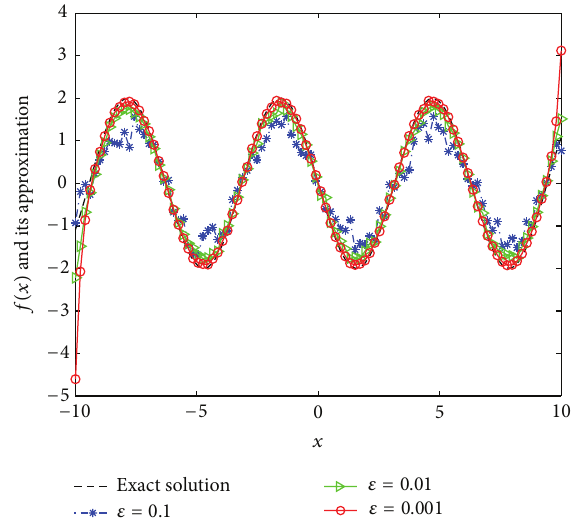
Figure 1: Comparison between the exact solution and its computed approximations with 𝑘 = 1 and various noise levels of 𝜀 = 0.1 , 𝜀 = 0.01 , 𝜀 = 0.001 for Example 5.